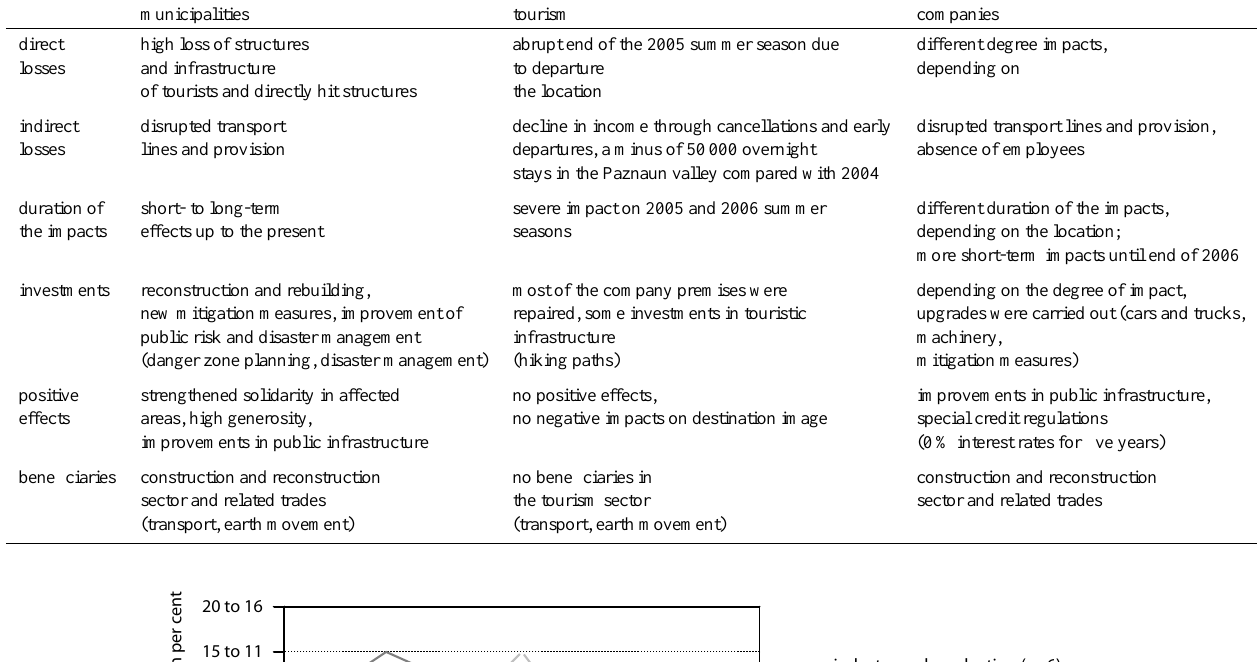
Table 2. Final summary table of the guided interviews.